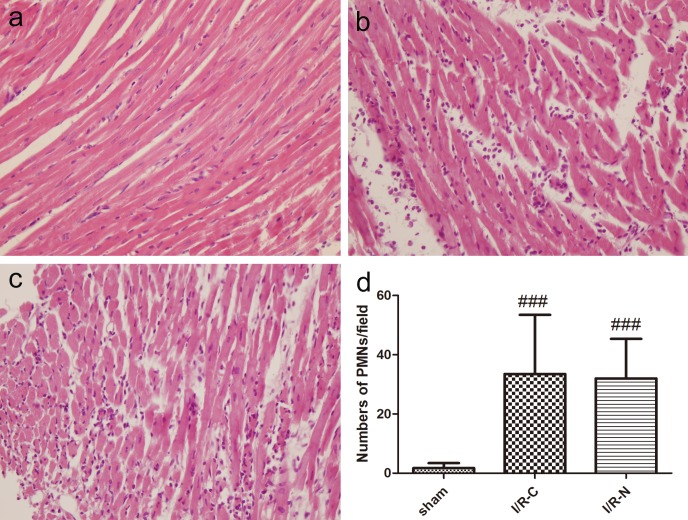
Neutrophil infiltration analysis.a-c. Representative hematoxylin-eosin staining myocardium images in sham group, I/R-C group and I/R-N group respectively (400×). Myocardium injury was serious within the ischemic areas of the heart after I/R. d. Neutrophil accumulation within the ischemic areas of the heart after I/R. Large number of neutrophil were accumulate in the cardiac ischemic areas after I/R (n = 4). ###p<0.001 vs sham group.